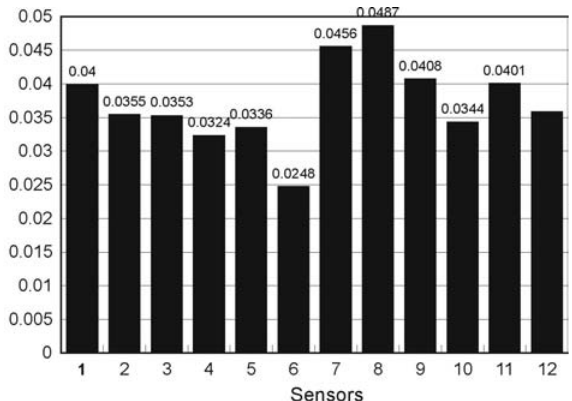
Fig. 6. The peak values of accelerations obtained by dif- ferent sensors